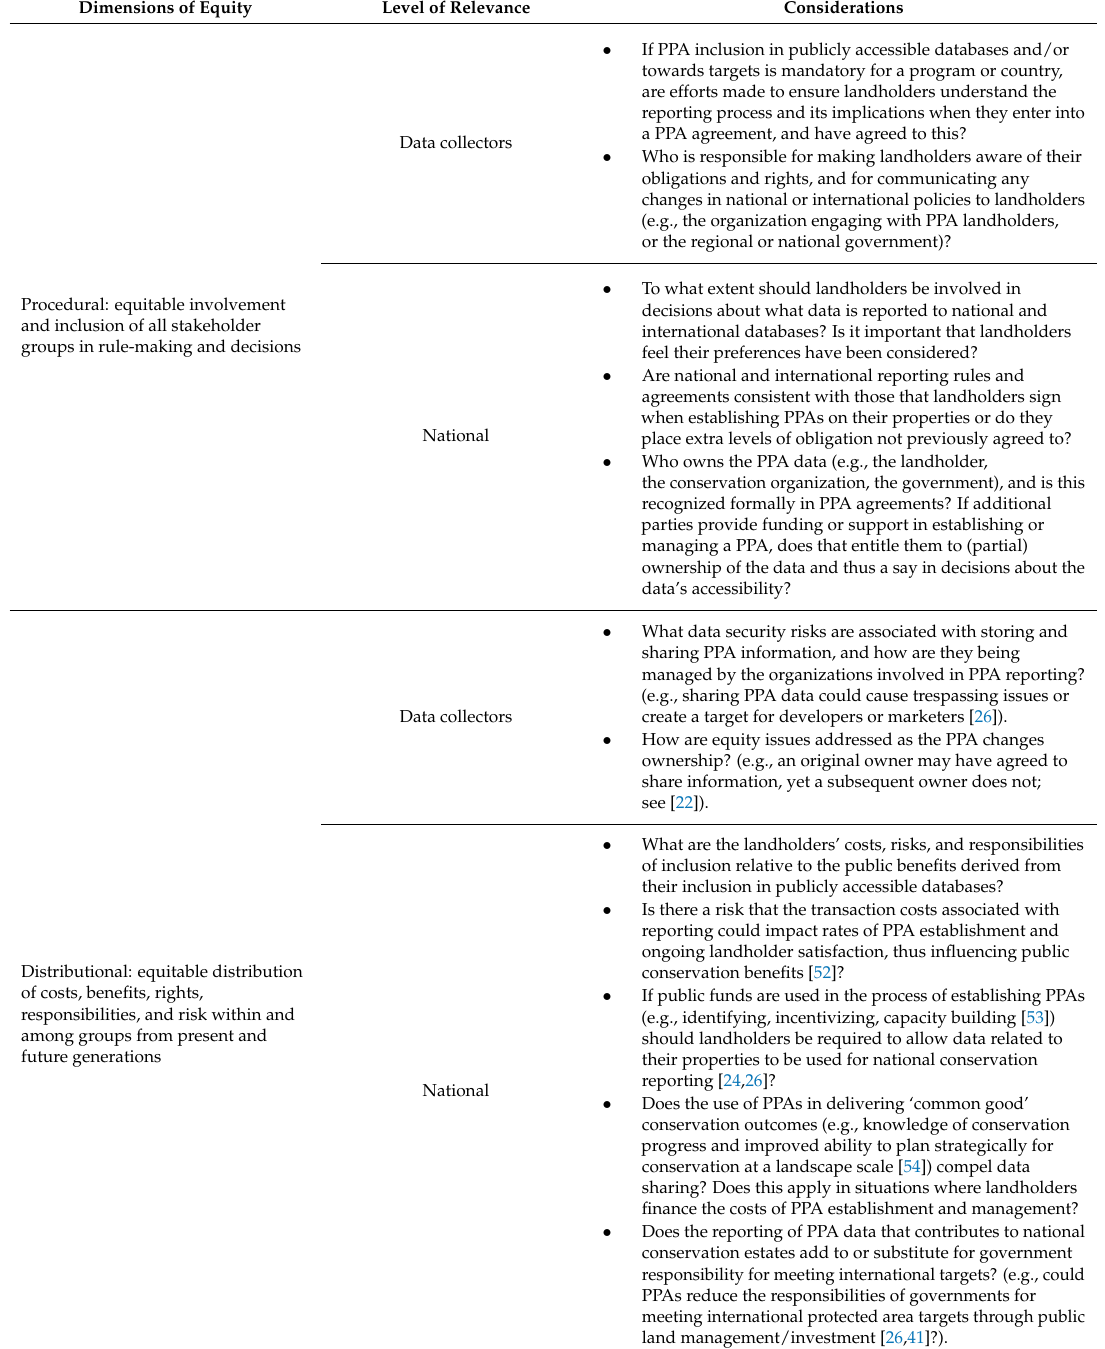
Table 1. Considerations of three dimensions of equity [48–50] in the inclusion of privately protected area (PPA) data (e.g., geospatial data, property name, management authority) in publicly available databases and towards national and international conservation targets. These considerations are relevant to the organizations that engage directly with landholders, facilitate PPA agreements, and collect PPA data (‘data collectors’; Figure 1). Some considerations are also relevant to the national organizations that collate this information and decide whether to contribute it to international